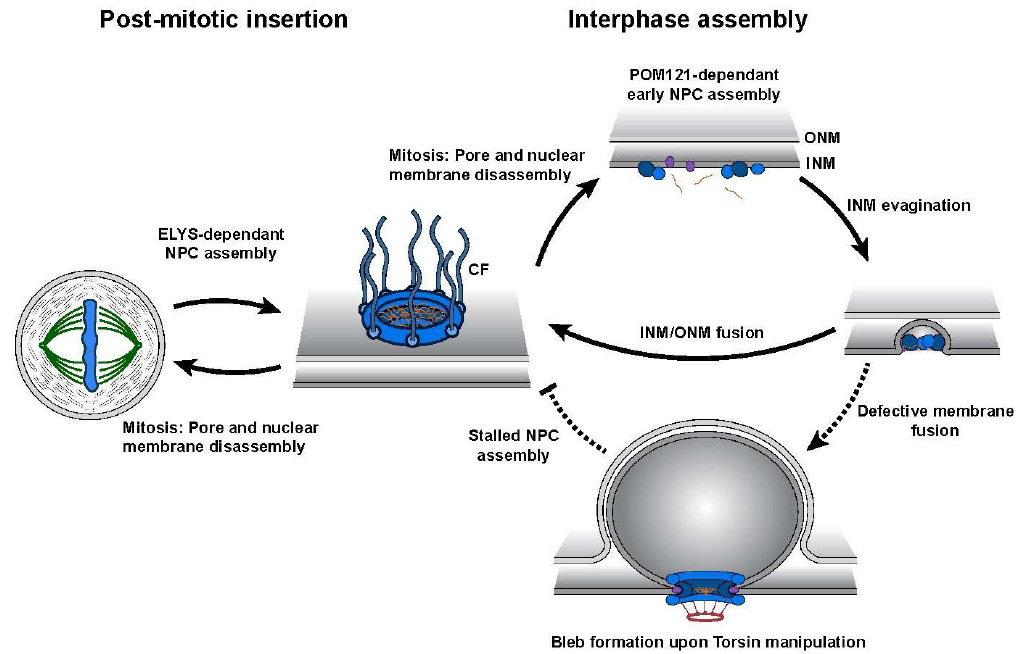
Figure 3 . Schematic representation of nuclear pore complex (NPC) biogenesis highlighting the two distinct assembly mechanisms. Post-mitotic insertion occurs during late mitosis where pre-existing NPC subcomplexes assemble at the reforming NE. Interphase assembly requires the de novo construction of NPCs into the double lipid bilayer of the NE. Upon Torsin manipulation, interphase assembly is stalled presumably prior to the fusion of the inner nuclear membrane (INM)/outer nuclear membrane (ONM). Note that cytoplasmic fibrils (CFs) containing NUP358 are only added to the nascent NPC after INM/ONM fusion during interphase assembly (i.e., the observed absence of NUP358 from blebs containing NPC components supports the idea of blebs representing stalled NPC assembly intermediates) [32,84].